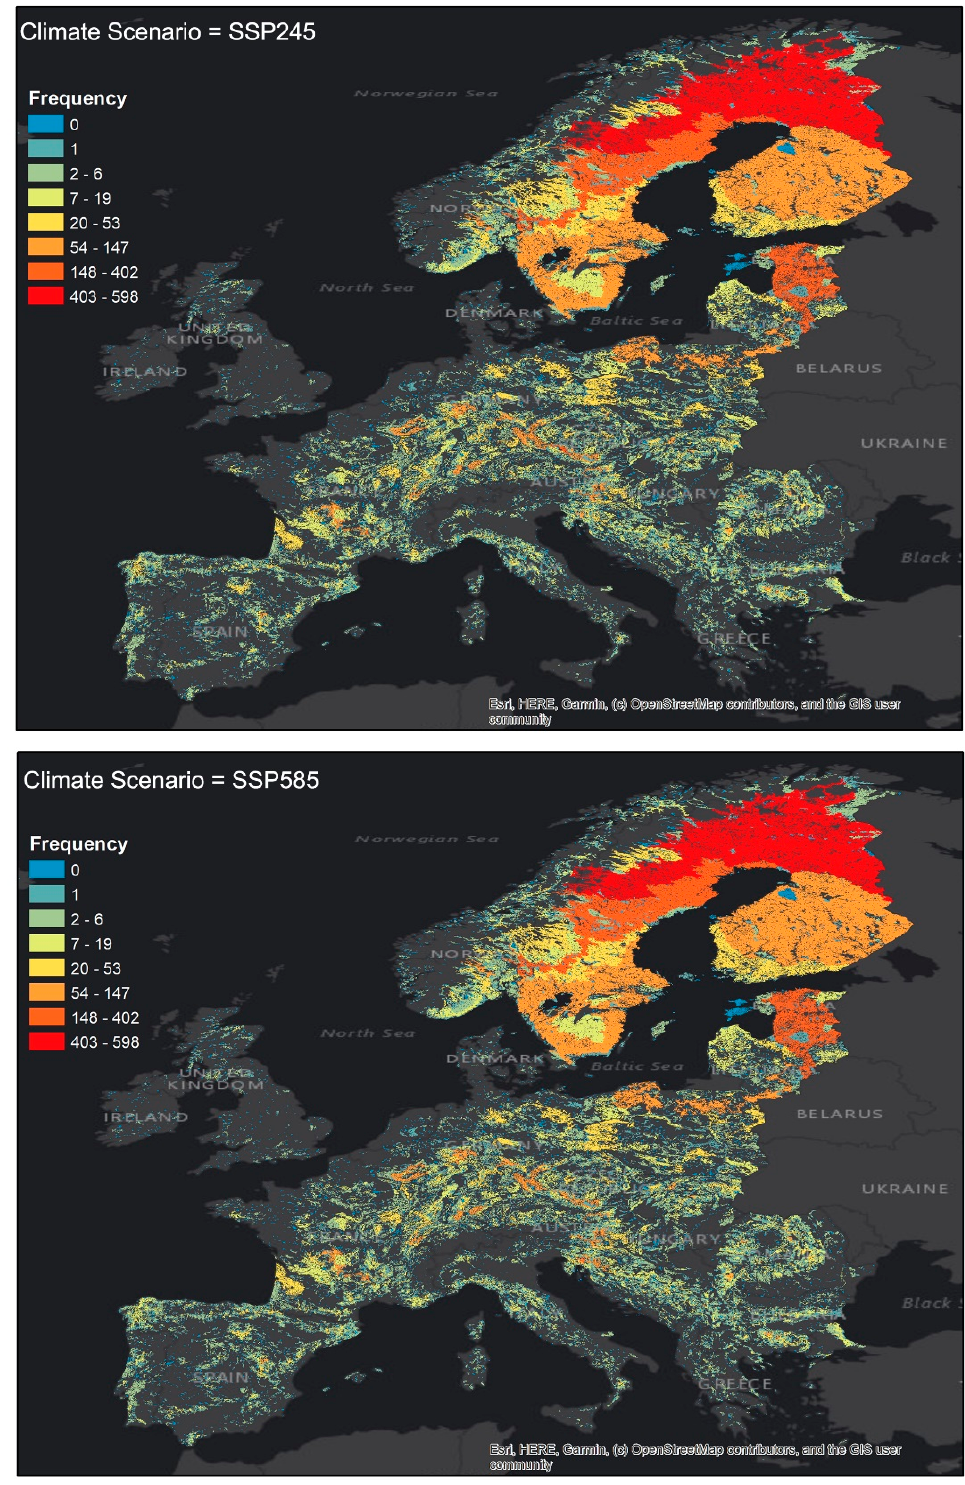
Figure 4. The potential (frequency) of forested areas to serve as stepping stones for climate-driven range shifts under the moderate (SSP245) and the most severe (SSP585) climate scenarios.